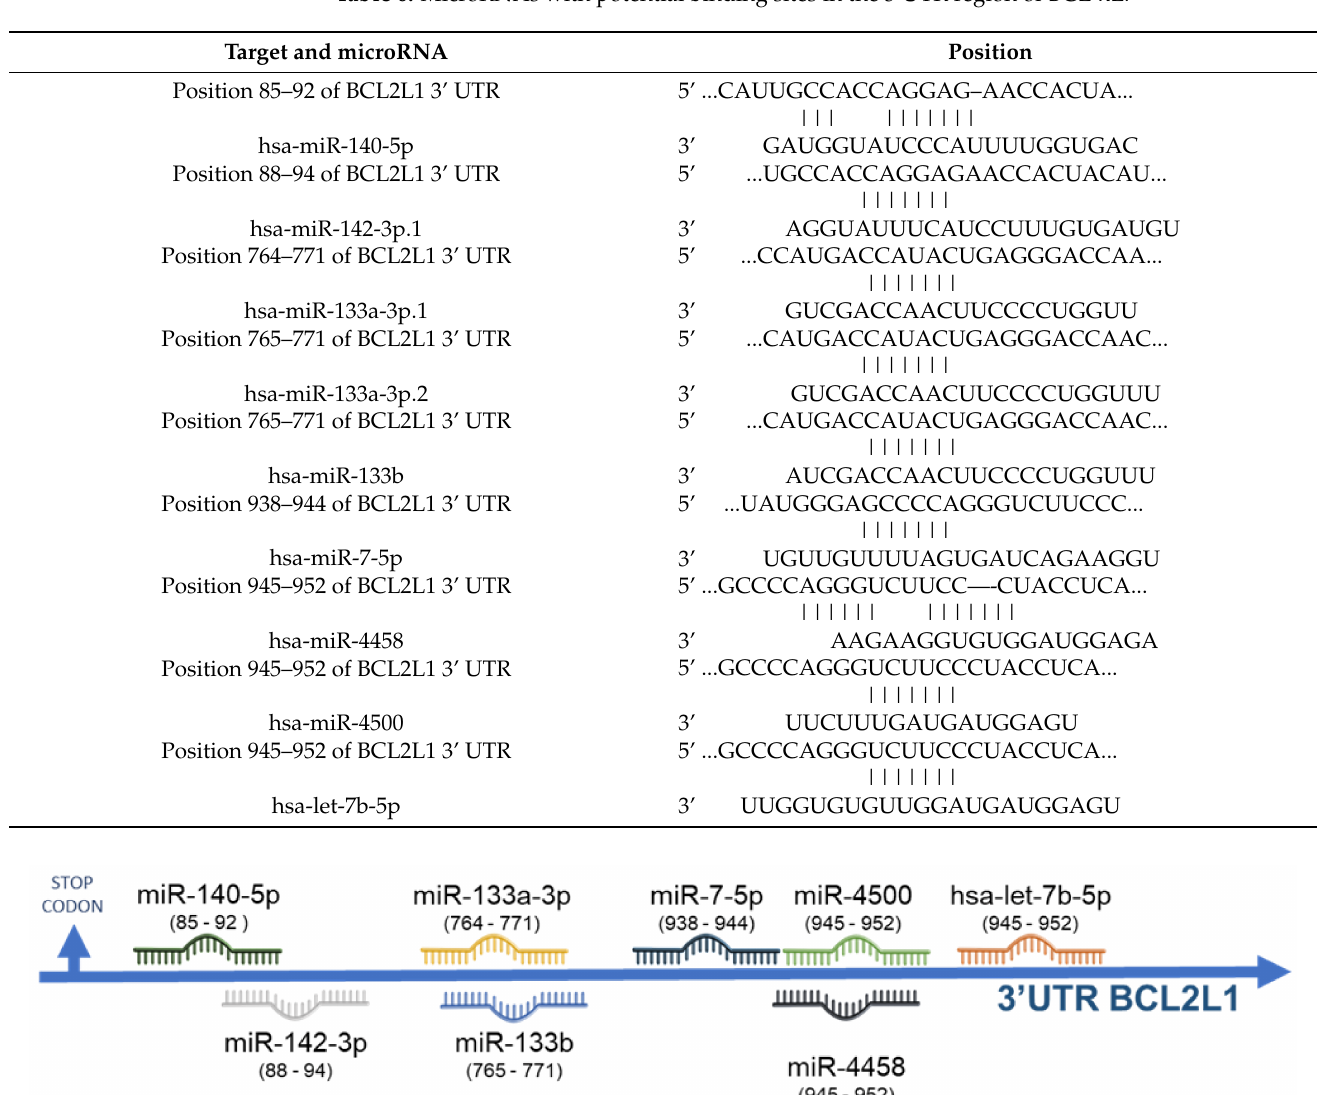
Table 6. MicroRNAs with potential binding sites in the 3’UTR region of BCL-xL.